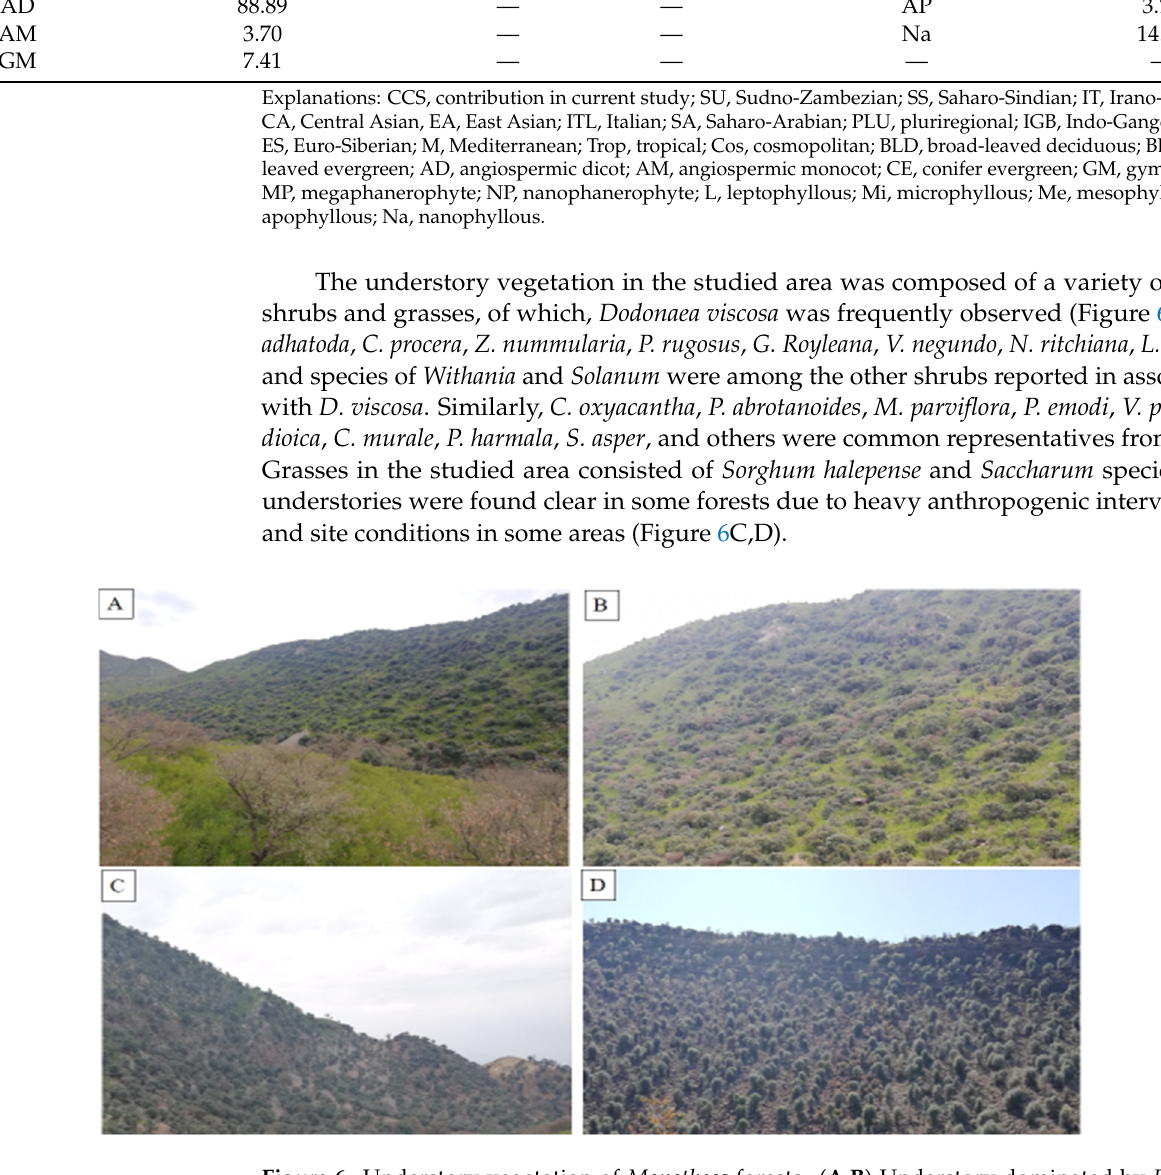
Figure 6. Understory vegetation of Monotheca forests. ( A , B ) Understory dominated by Dodonaea viscosa , ( C , D ) clear understory vegetation.